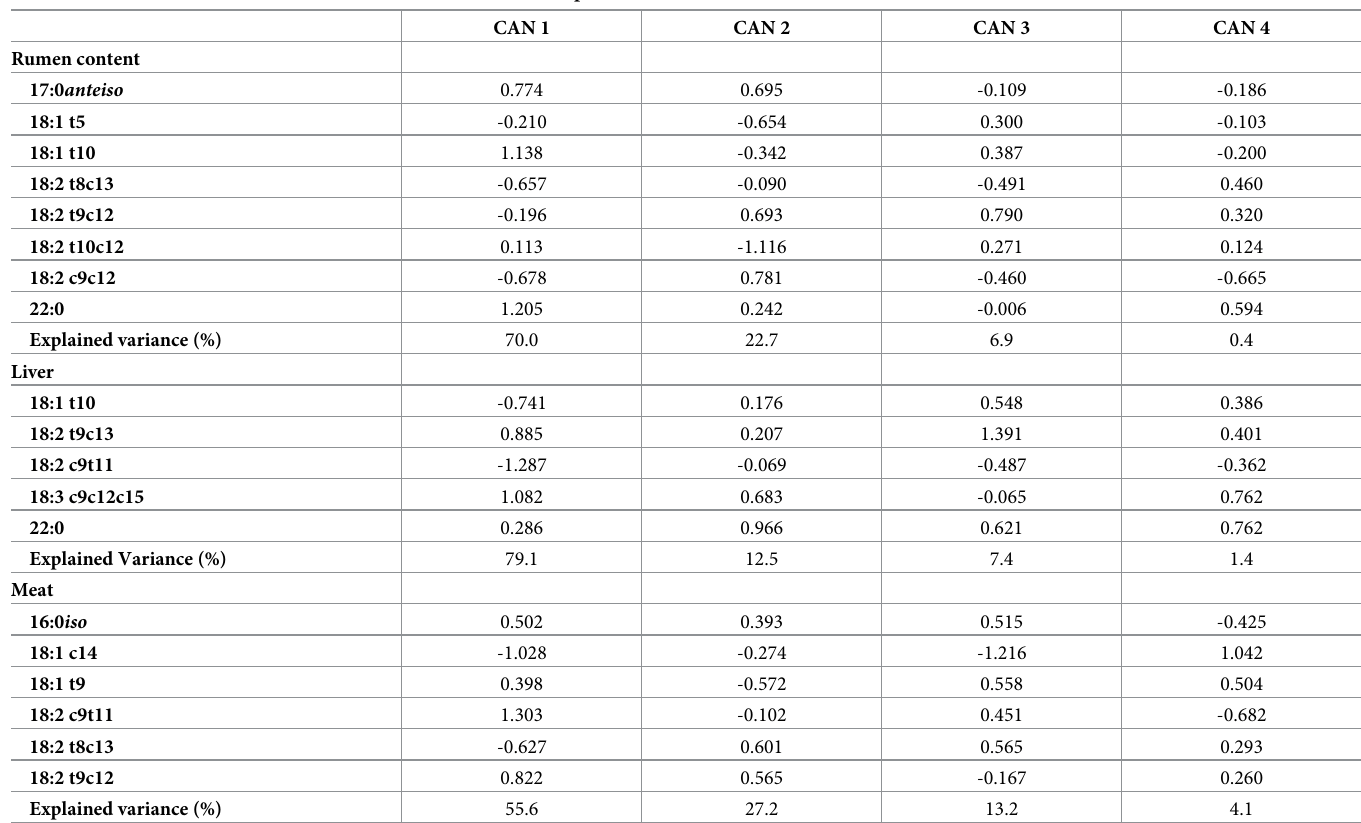
Table 6. Standardized coefficients of each canonical function and explained